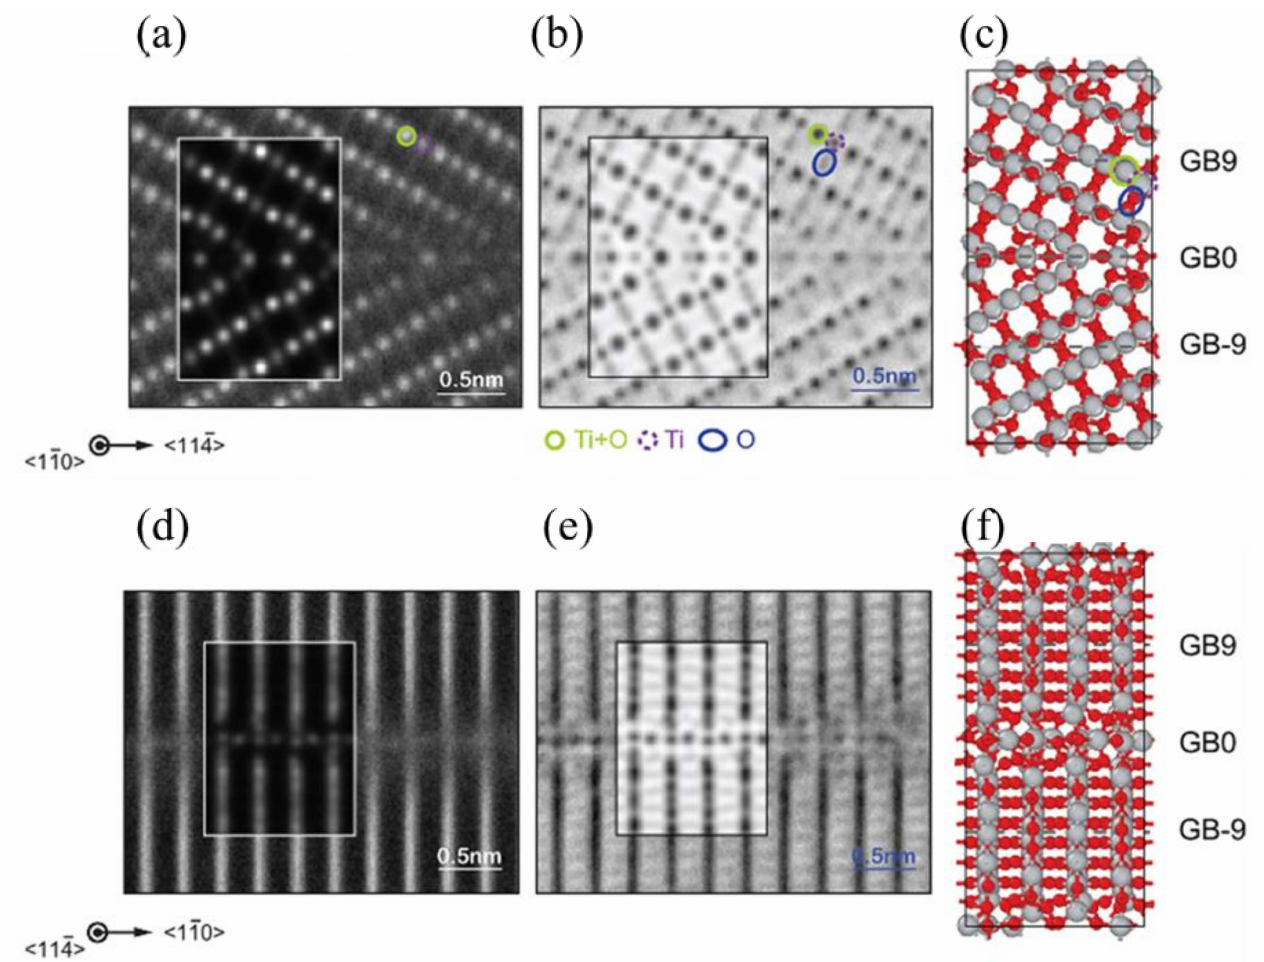
Figure 25. Atomic resolution HAADF, ABF STEM images and the DFT atomic structure of the Σ 13 bicrystal along the (cid:2) (cid:3) (cid:2) (cid:3) ( a – c ) 110 and ( d – f ) 114 , respectively. Image simulations based on the atomic structure of rutile are shown as insets in the experimental HAADF and ABF STEM images. Gray and red spheres represent Ti and O atoms, respectively. Columns of Ti + O, Ti, and O atoms are marked by solid green circles, dashed purple circles, and blue ellipsoids, respectively [216]. Figure 25 reprinted from https://pubs.acs.org/doi/full/10.1021/acs.nanolett.0c04564 (accessed on 27 May 2021) under the terms of the Creative Commons CC BY license. Further permissions related to the material excerpted should be directed to the